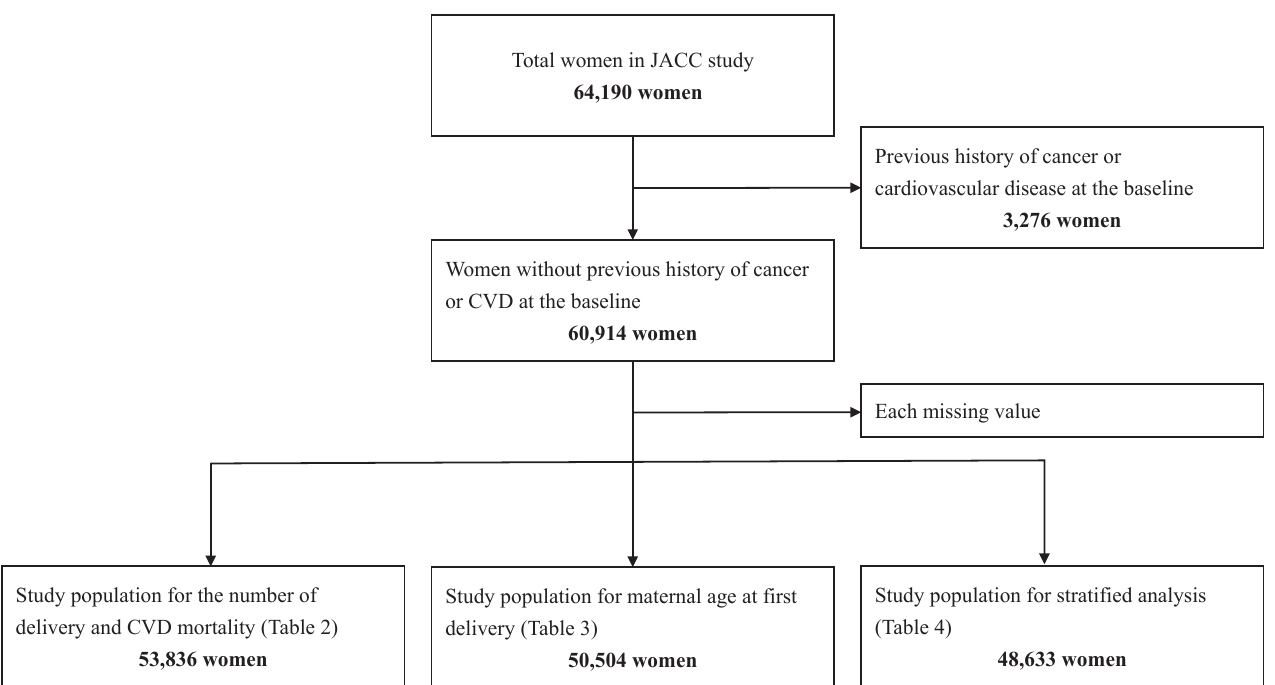
Figure 1. Flowchart of study exclusion and